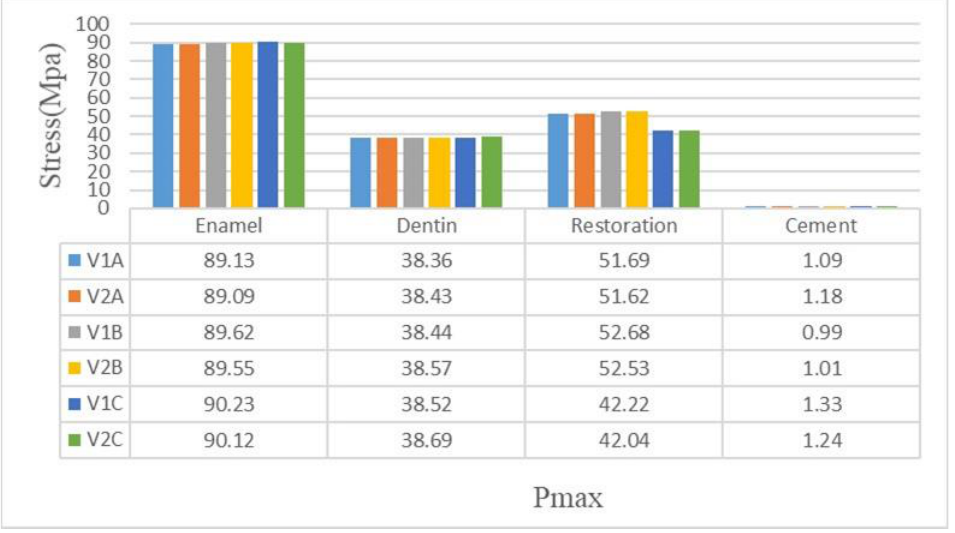
Figure 5. Maximum principal stress (MPa) distribution within the enamel, dentin, restoration, and different thicknesses of resin cement in each group under 600 N of total force applied to the occlusal surface.